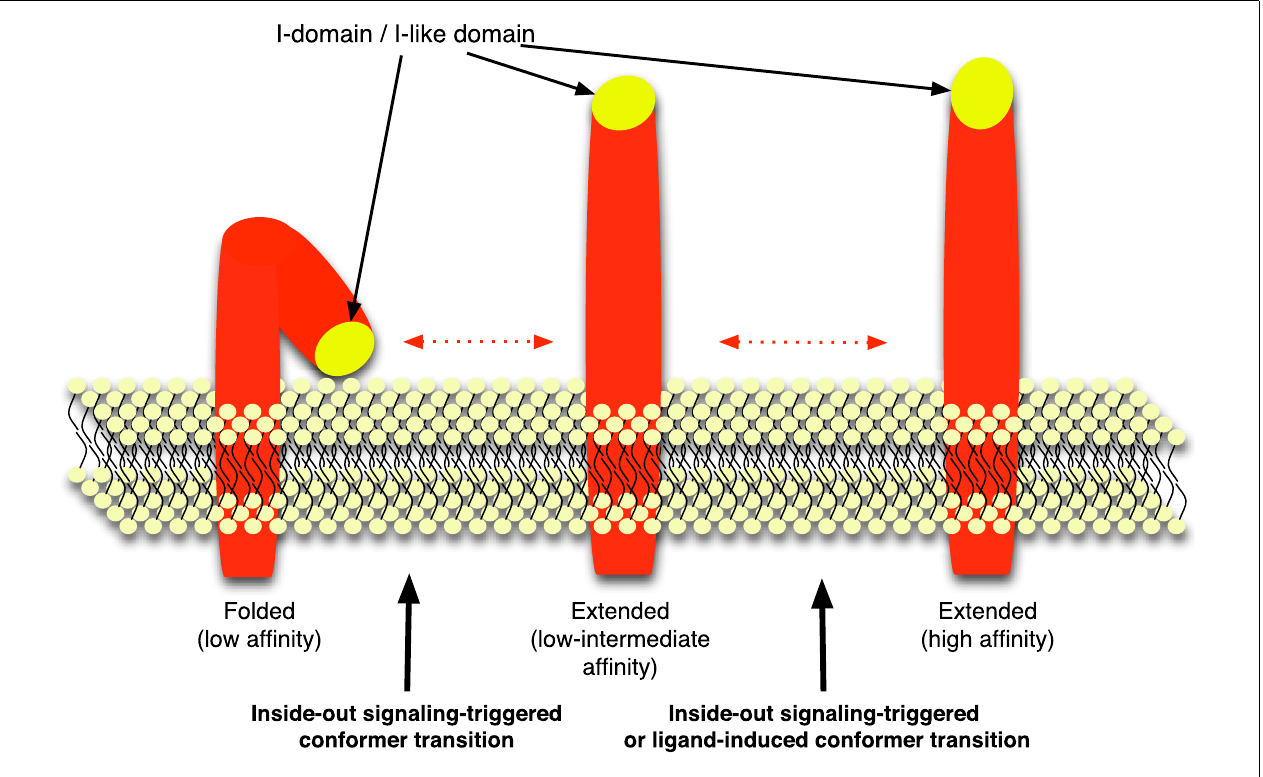
FIGURE 1 | Integrin affinity triggering. The diagram refers to the LFA-1 affinity-triggering model. Shown is the dynamic equilibrium between three conformers displaying low-, low/intermediate-, and high-affinity for ICAM-1.